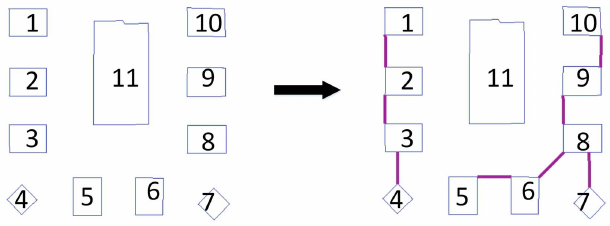
Figure 6. Computing bottlenecks where a user with a given dimension cannot